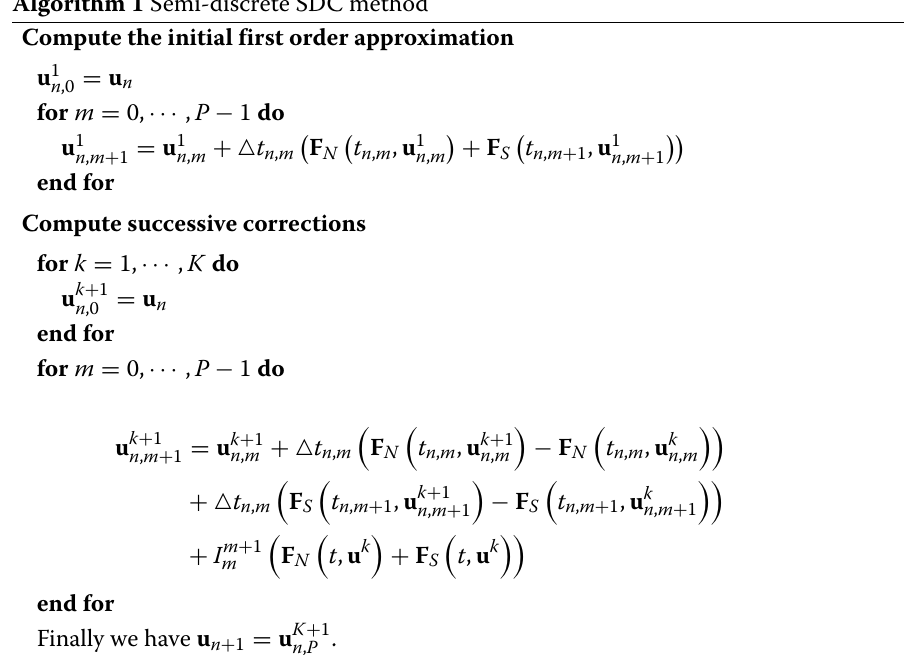
Algorithm 1 Semi-discrete SDC